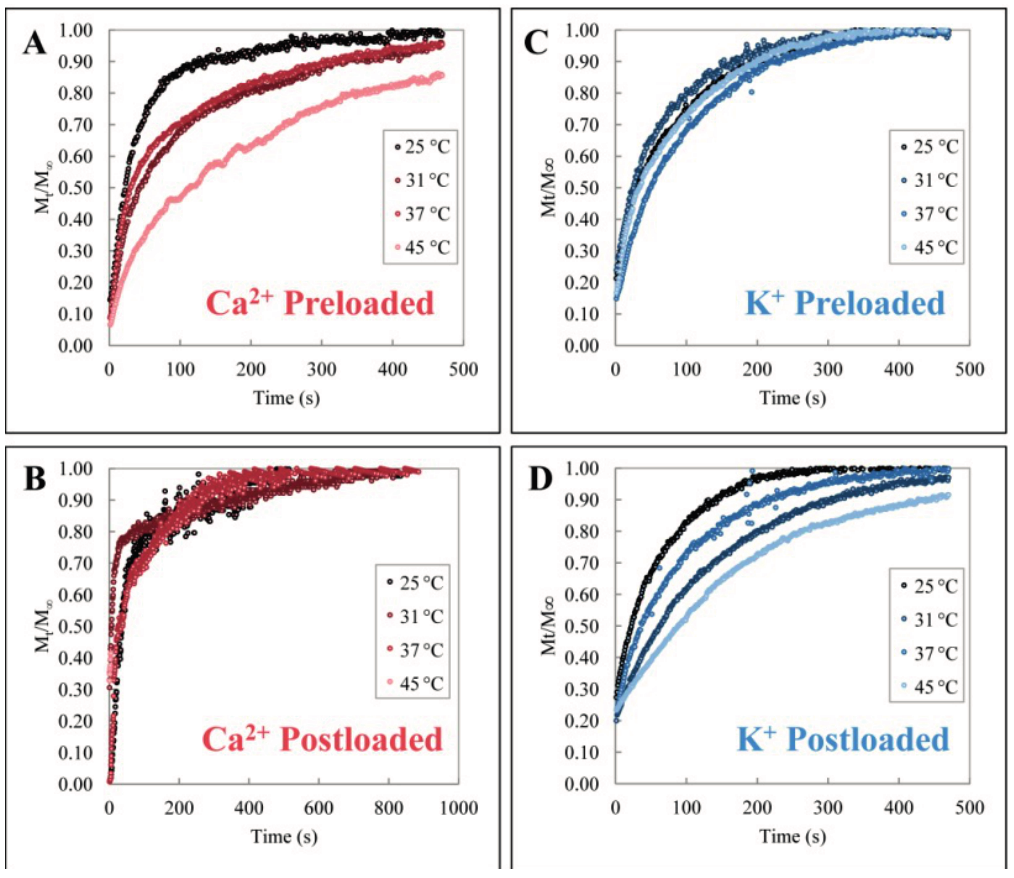
Figure 2. Normalized release profiles of pre- ( A , C ) and post- ( B , D ) loaded Ca 2+ ( A , B ) and K + ( C , D ) ions from pHEMA-based hydrogel